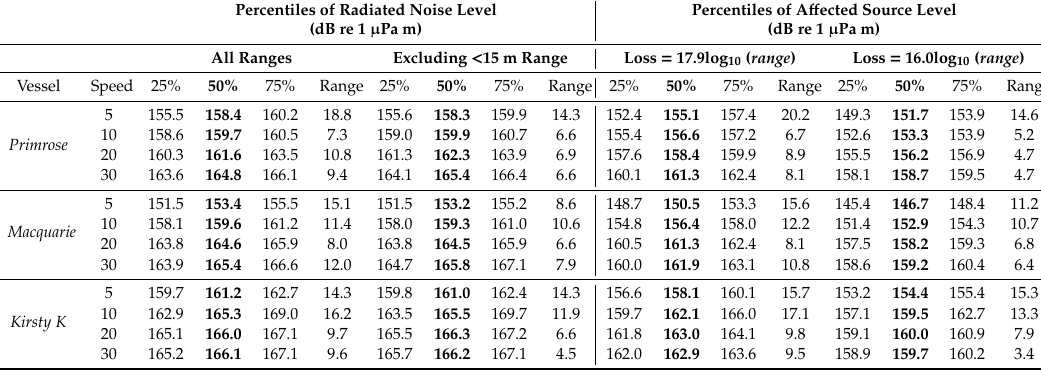
Figure 5. Affected source levels using the average linear regression-determined propagation loss across all vessels, excluding ranges below 15 m (16.0log 10 { range }) for Primrose at category speeds of 5, 10, 20 and 30 km h − 1 (green dots, beige diamonds, red circles and blue square, respectively). Table 4. Percentiles and maximum ranges of radiated noise levels and of affected source levels for the average log 10 ( range ) losses across modelled losses for individual vessels and speeds using all ranges and using all ranges >15 m.